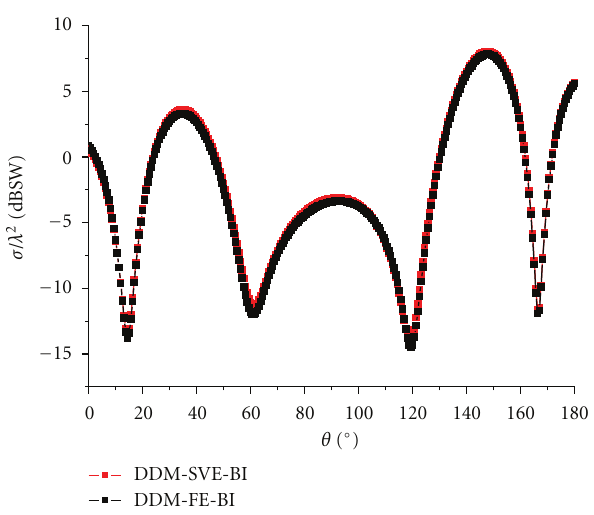
Figure 11: The Bistatic RCS of two coating PEC